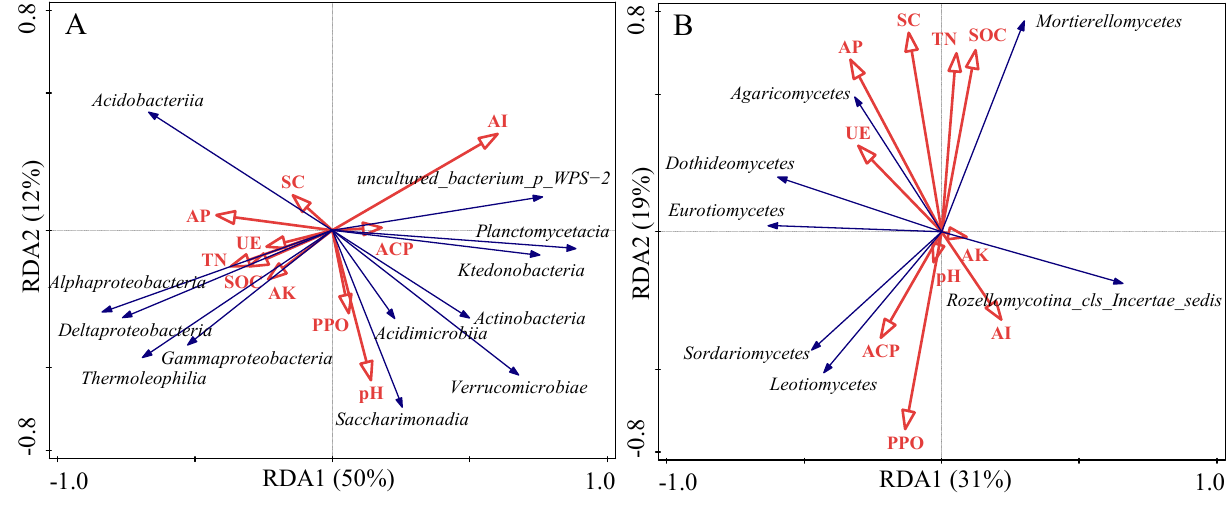
Figure 3. Redundancy analysis (RDA) of soil bacteria ( A ) and fungi ( B ) at class level and soil chemical properties and enzymatic activity. pH, soil potential of hydrogen potential of hydrogen; SOC, soil organic carbon; TN, total nitrogen; AP, available phosphorus; AK, available potassium; SC, sucrase; UE, urease; ACP, acid phosphatase; AI, acid invertase; PPO, polyphenol oxidase. Table 5. Relationships between microbial community at class level and alpha diversity, soil chem ‐ ical properties, and enzymatic activity.